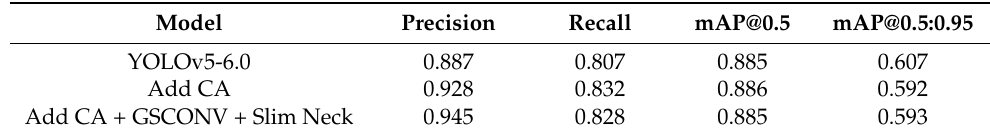
Table 5. Comparison of the models after the introduction of GSConv and Slim-Neck methods in the Neck layer with the model before the improvement.